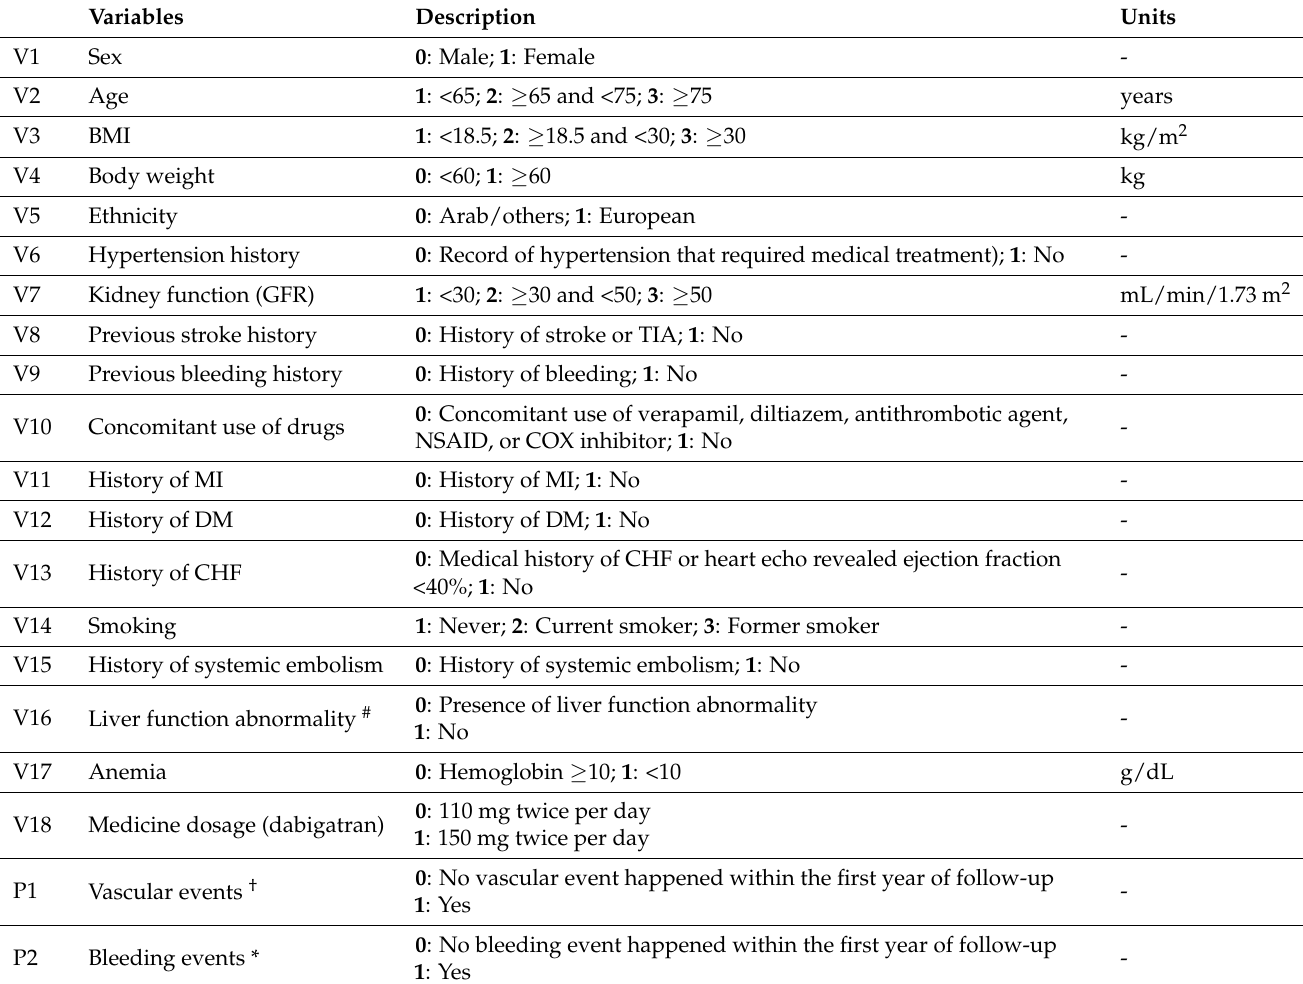
Table 1. Description of predictor and target variables in this